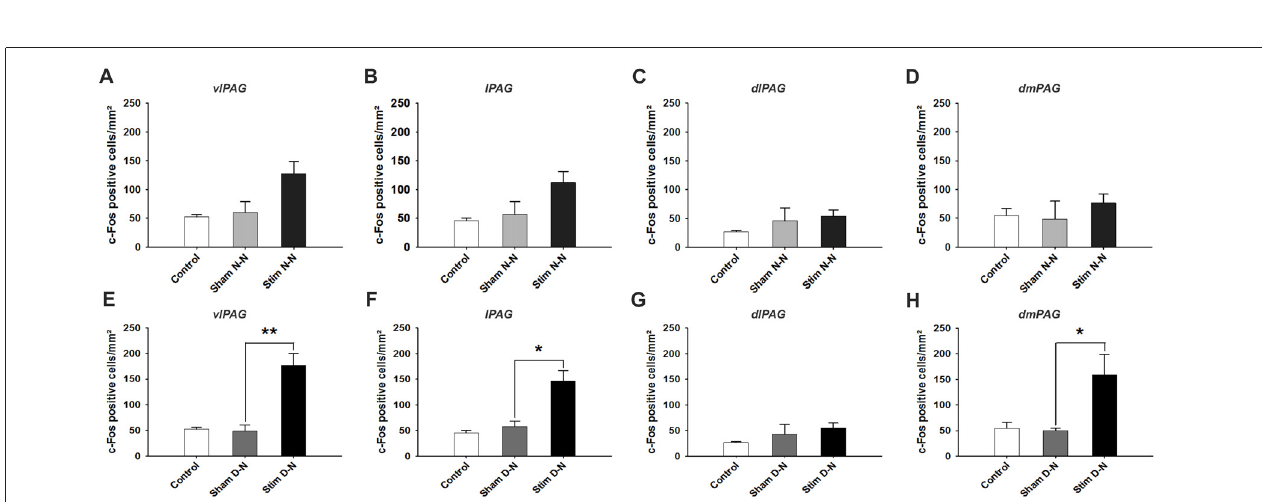
FIGURE 4 | Expression of cFos immunoreactive cells in the caudal PAG. Cumulative data showing the means and SEM of cFos expression for N-N animals in the caudal (A) vlPAG, (B) lPAG, (C) dlPAG, (D) dmPAG and for D-N animals in the caudal (E) vlPAG, (F) lPAG, (G) dlPAG, (H) dmPAG. Control n = 12, Sham N-N n = 12, Sham D-N n = 12, Stim N-N n = 14 and Stim D-N n = 14. t -test, ∗ p < 0.05 and ∗∗ p <